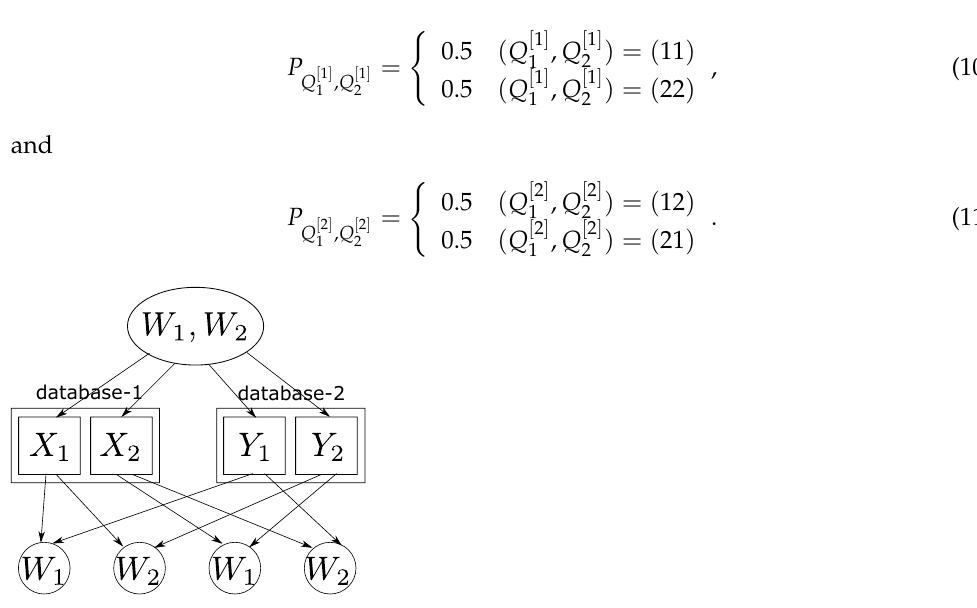
Figure 1. A possible coding